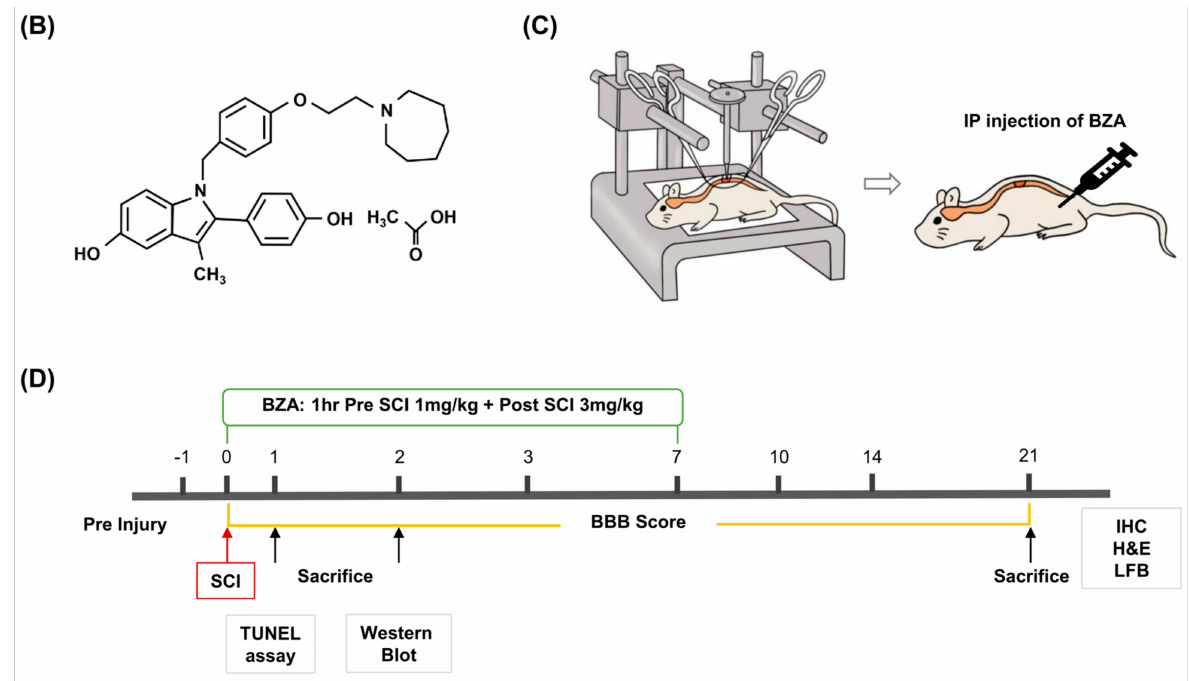
Figure 8. Schematics of the predicted mechanisms of BZA and experimental design. Illustration of spinal cord injury (SCI) modeling and the scheme of the overall experiment. ( A ) Schematic diagram of the effect of BZA after SCI. ( B ) Chemical structure of BZA. ( C ) Creation of moderate static compressive SCI and intraperitoneal (i.p.) injection of treatment materials. ( D ) Schematic overview of the total experimental